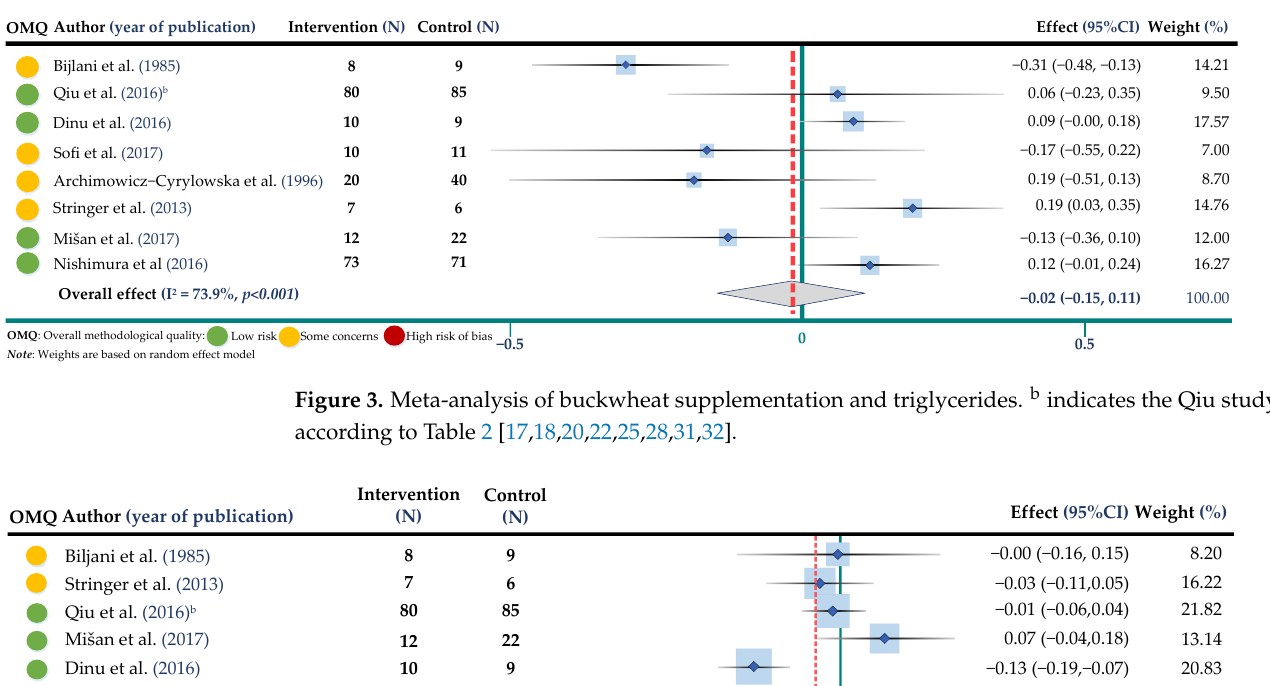
Figure 2. Meta-analysis on buckwheat supplementation and total cholesterol. b indicates the Qiu study according to Table 2 [17,18,20,22,25,28,31,32].